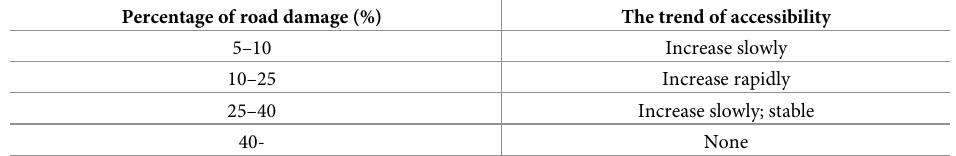
Table 9. S-curve change trend of distribution cost of 65–38.